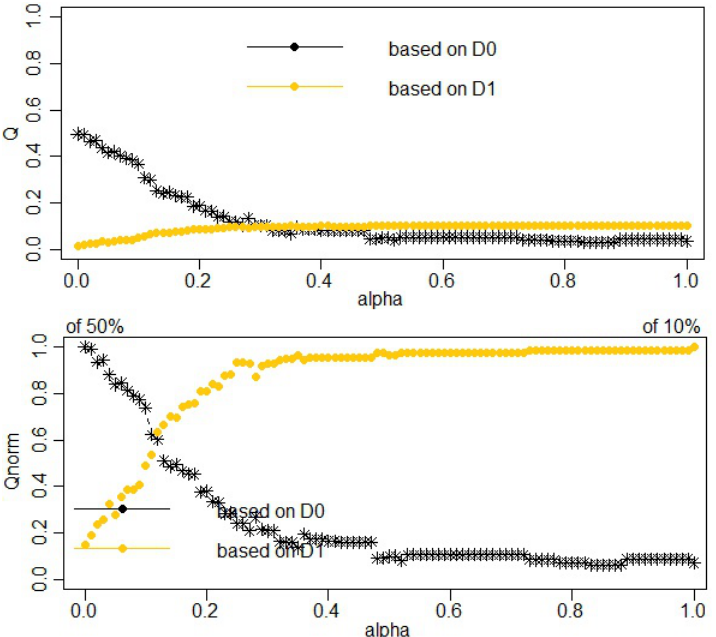
Figure 5. Choice of α for a partition in K = 5 clusters when D 1 is the neighborhood dissimilarity matrix between municipalities. ( Top ) proportion of explained pseudo-inertias Q 0 ( P α ) versus α (in gold dashed line). ( Bottom ) normalized proportion of explained pseudo-inertias and Q 1 ( P α K ( P α ) versus α (in black solid line) and Q ∗ Q ∗ K 0